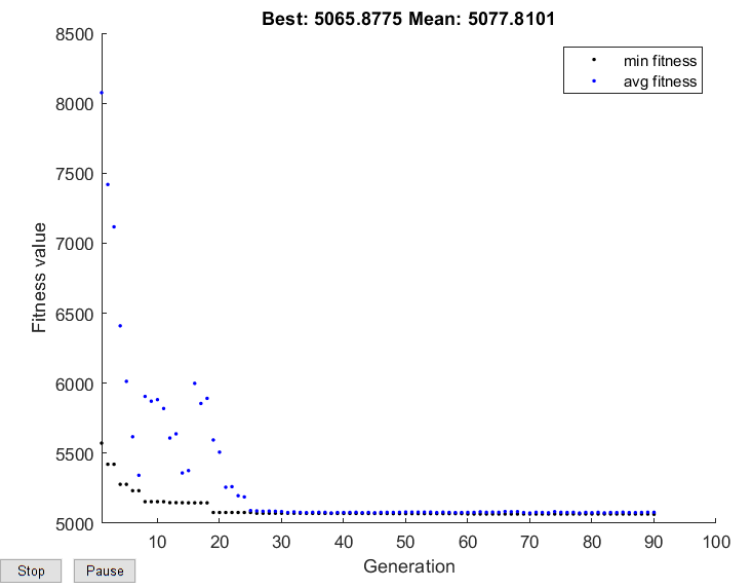
Figure 8. Best and average fitness evolution in control strategy #1 when minimizing OQI .